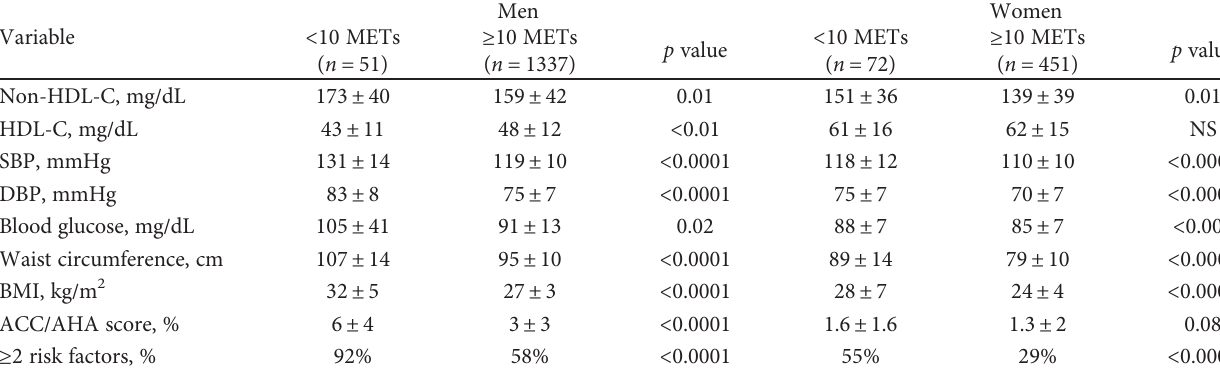
Table 2: Biochemical and anthropometrical variables according to aerobic capacity in subjects < 55 years old. Variable